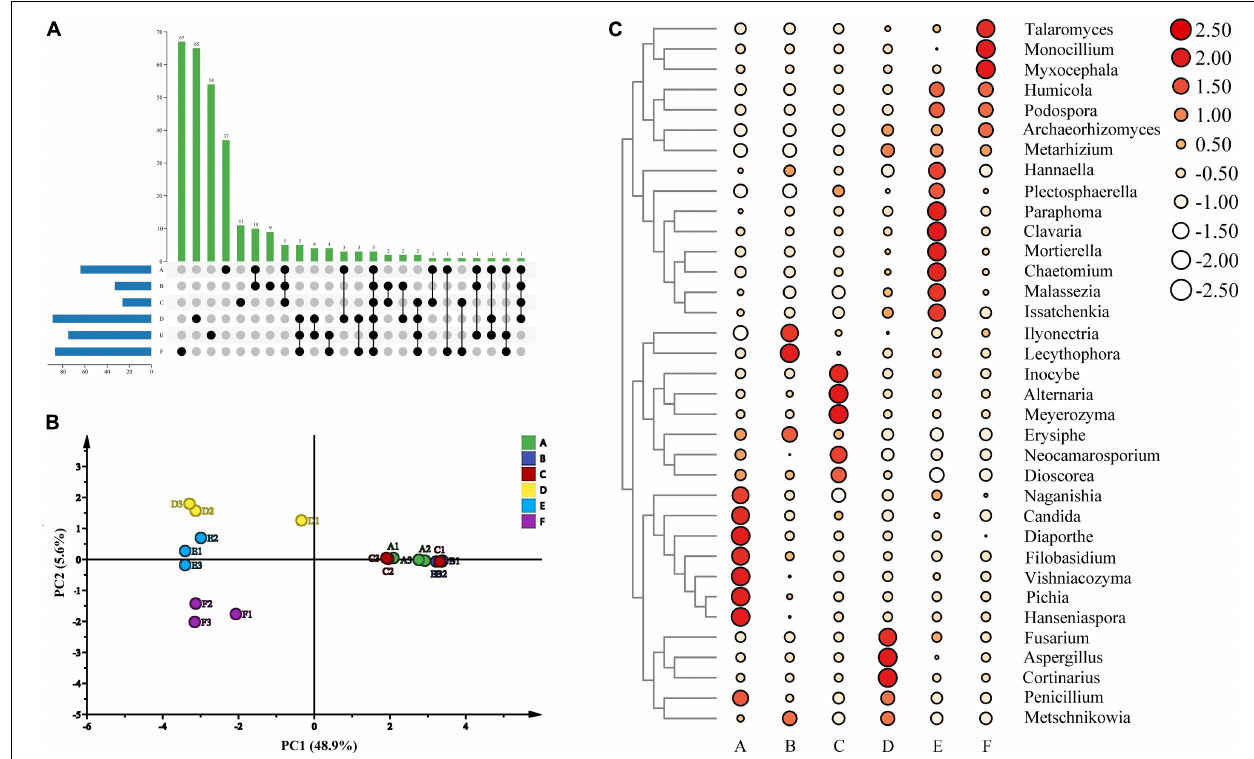
FIGURE 5 | The upset diagram of the fungi genus among samples (A) , PCA of wine samples (B) , abundance clustering heatmap of major fungi genera in zymotic fluids collected from different fermentation times (C) . The scale bar shows the relative abundance (log scale) of each genus within a sample. A, B, C, D, E, and F represented samples collected on fermentation days 0, 1, 4, 7,11, and 14,